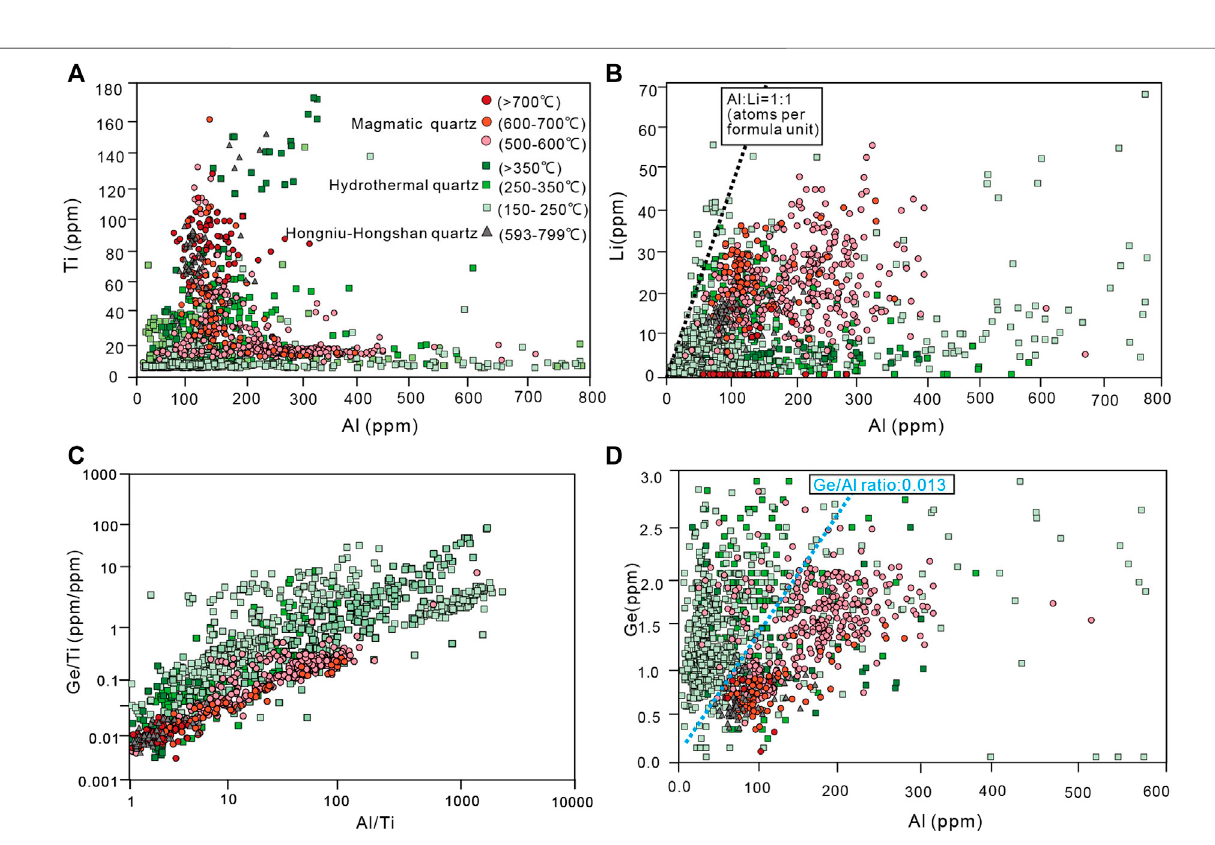
Frontiers in Earth Science |